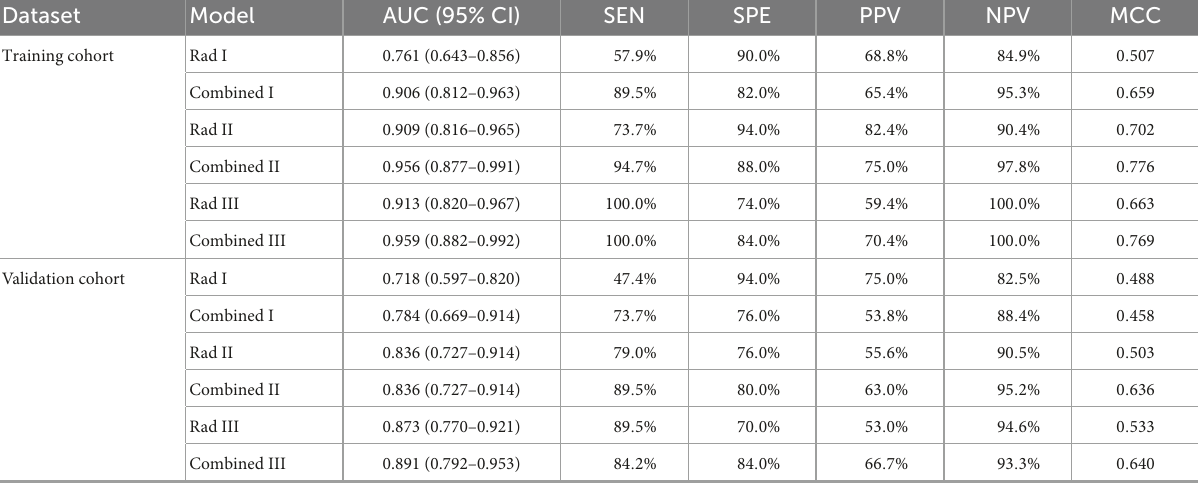
TABLE 4 Prediction effectiveness of radiomics and combined models in the training and validation cohorts. Dataset